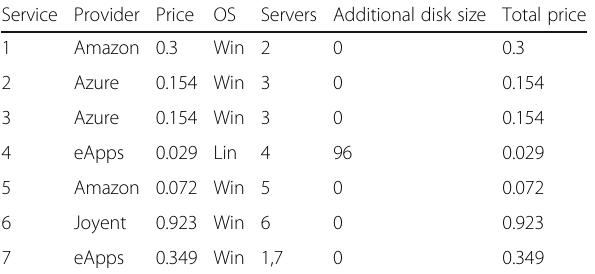
Table 5 Results of service consolidation for the tested application Table 6 Results of service consolidation for the